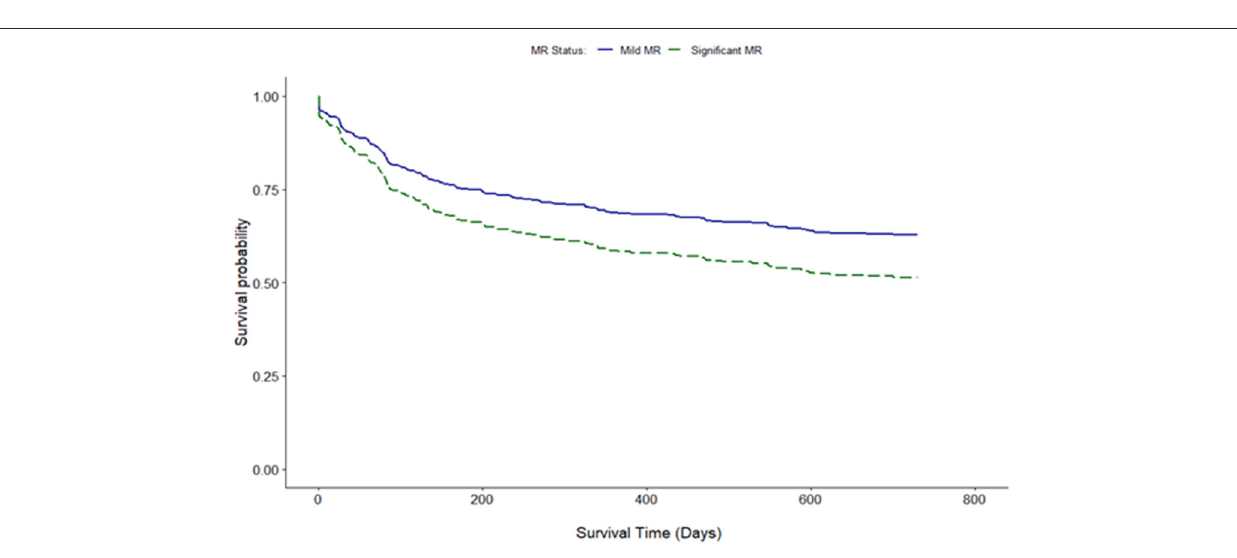
mild MR individuals due to insufficiency of jets. Trivial ( < 4%) numbers of LV/sPAP measurements were not